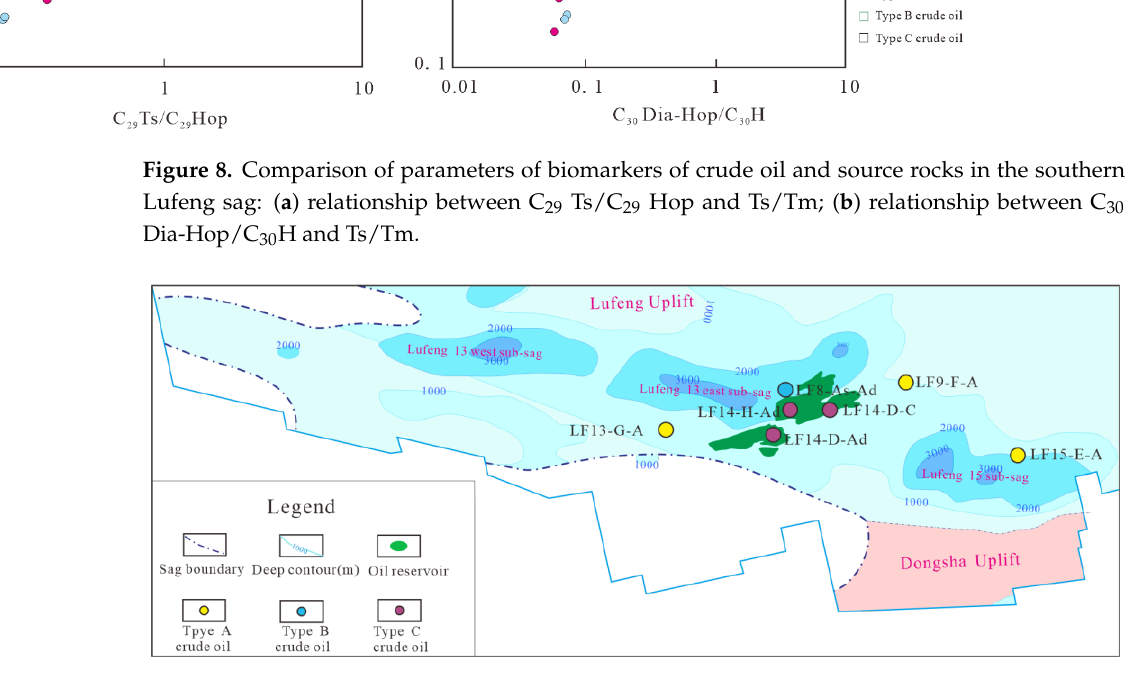
Figure 8. Comparison of parameters of biomarkers of crude oil and source rocks in the southern Lufeng sag: ( a ) relationship between C 29 Ts/C 29 Hop and Ts/Tm; ( b ) relationship between C 30 Dia- Hop/C 30 H and Ts/Tm.